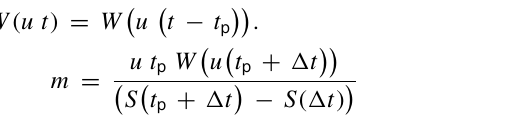
interplay of basin and climatic characteristics, and are calcu- lated as values associated with the maximum peak